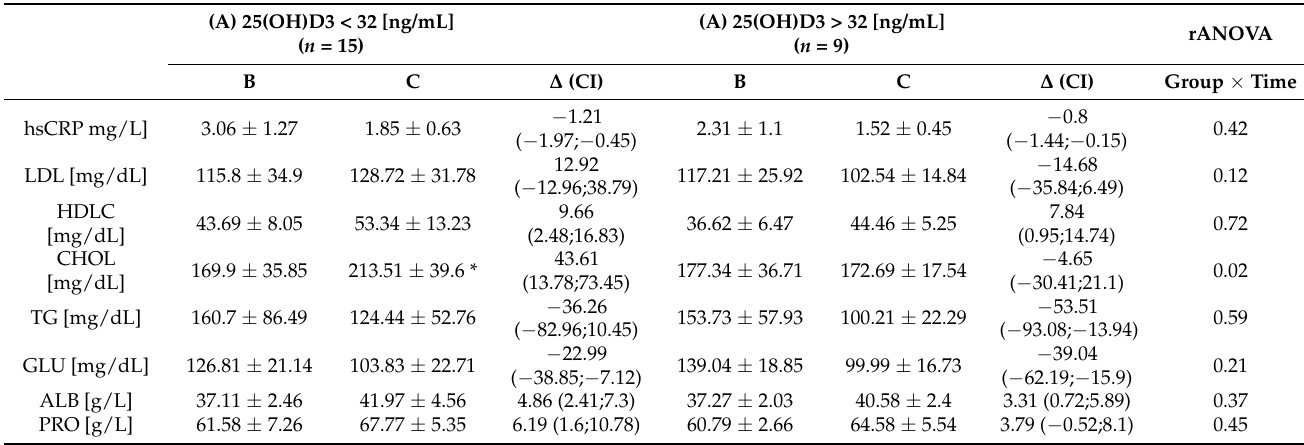
Table 3. Effects of bariatric surgery on analyzed parameters—the role of vitamin D. Analysis of Biochemistry data between reference points B vs. C divided into two groups considering the baseline level of 25(OH)D3 at 32